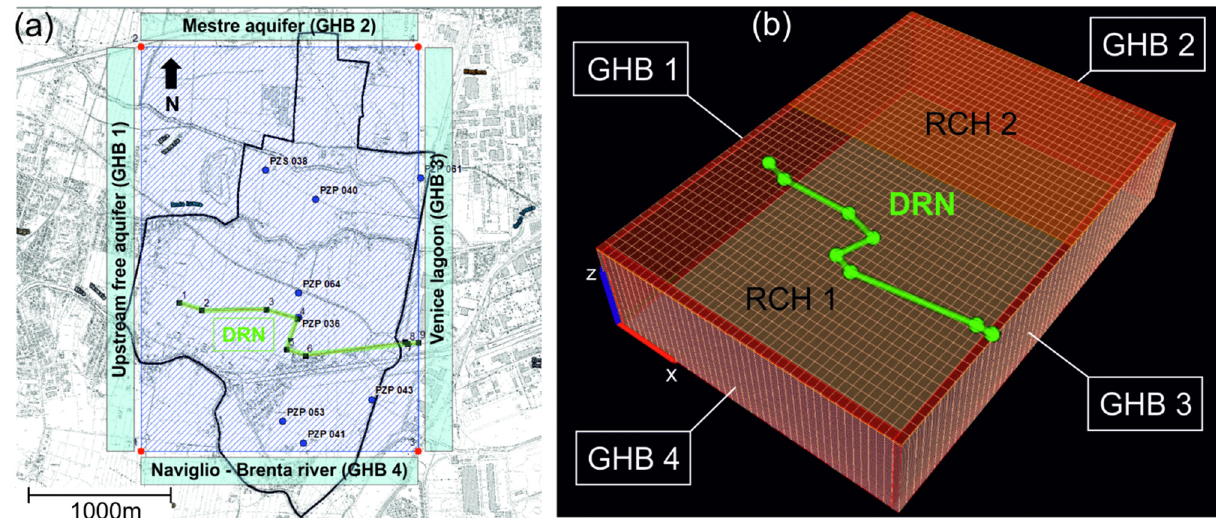
Figure 2. ( a ) The model extension on top of the technical topographic map of the studied area, showing the position of the eight piezometers (“PZP”) monitored in the December 2017 campaign. The figure also shows the lateral flow boundary conditions (BCs), implemented as General Head Boundaries (“GHB”), and the drain (“DRN”). On the DRN, the numbers represent the nodes used to build the drain’s feature in the model. ( b ) The discretized mesh of the PHAST model, illustrating the position of the GHBs and DRN BCs as well as the zonation of the recharge (“RCH”) BCs.